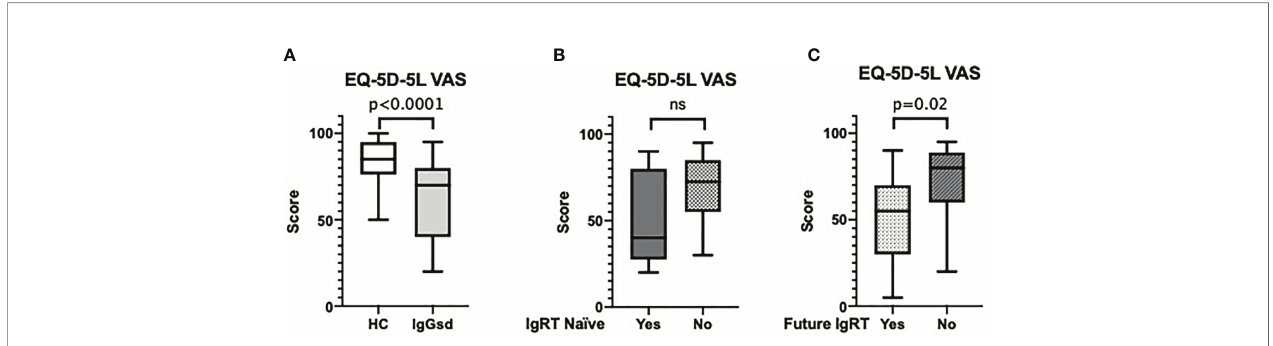
FIGURE 2 | IgGsdself-reported QoLby the EQ-5D-5LVAS. IgGsd individualsreported poorer overallQoLby EQ-5D-5LVAS than healthycontrols (A) . Atbaseline there were nodifferences in EQ-5D-5LVAS scores between treatment naïve IgGsd individuals(n=12)and individuals(n=23) already on IgRT (B) . After 18 monthsof IgRT discontinuation, at time-point 36 monthsEQ-5D-5L VAS scores were poorer in IgGsdindividuals(n=12) that needed to reintroduce IgRT compared to individuals (n=13)who did not (C) . VAS, visual analogue scale; QoL, quality of life; IgGsd, immunoglobulin subclass de fi ciency;IgRT, immunoglobulin replacement therapy; ns, not signi fi